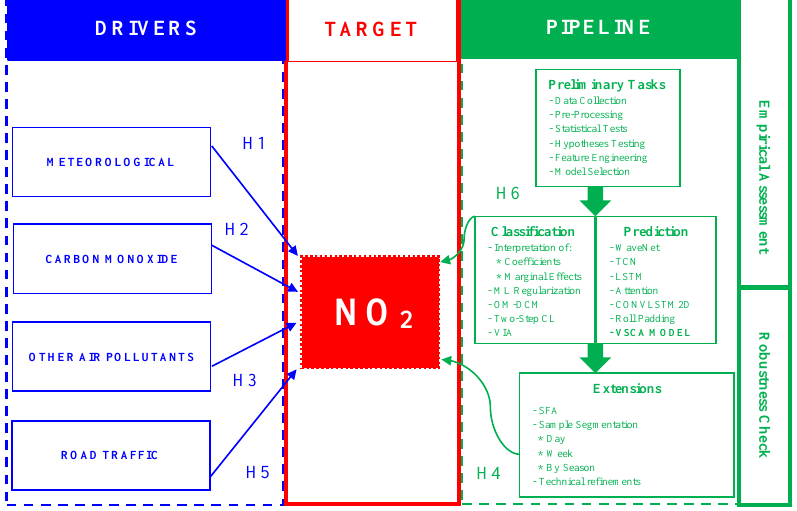
Figure 8. Conceptual framework, research hypotheses and methodological